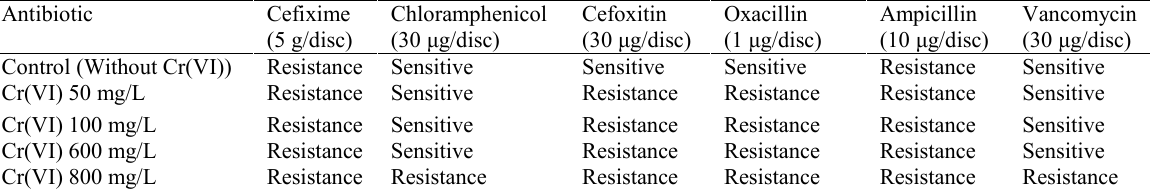
Table 2. Result for Antibiotic resistance